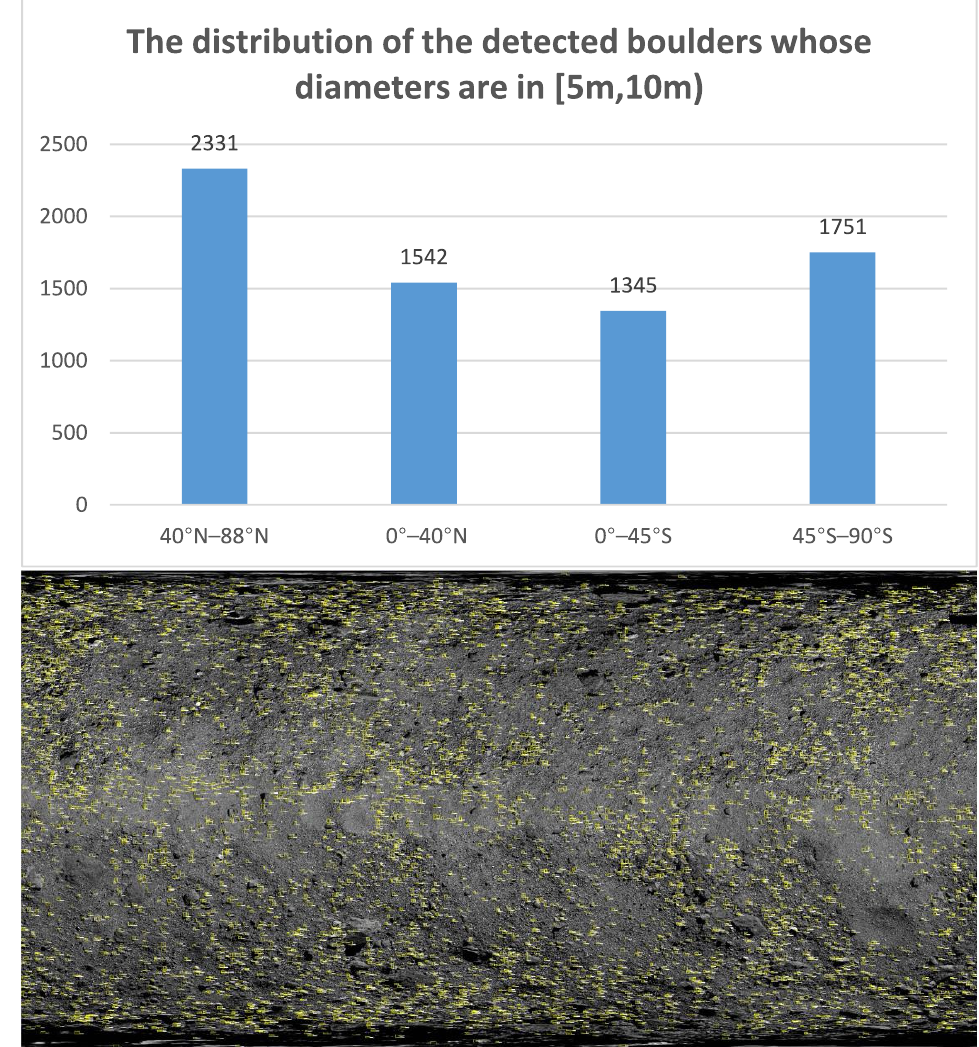
Figure 8. The distribution of the detected boulders whose diameters are between 5 m and 10 m in each